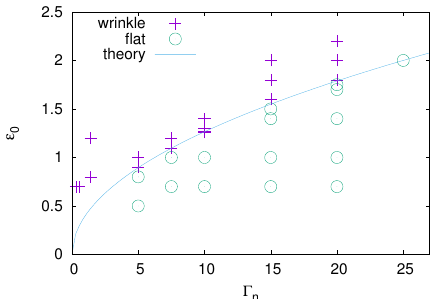
Figure 7. Phase diagram of wrinkle emergence. The horizontal and vertical axes are the parameter relating to the interfacial toughness and the initial in-plane strain, respectively. The solid curve corresponds to Equation (16), which is given by the linear stability analysis. Symbols are data of numerical